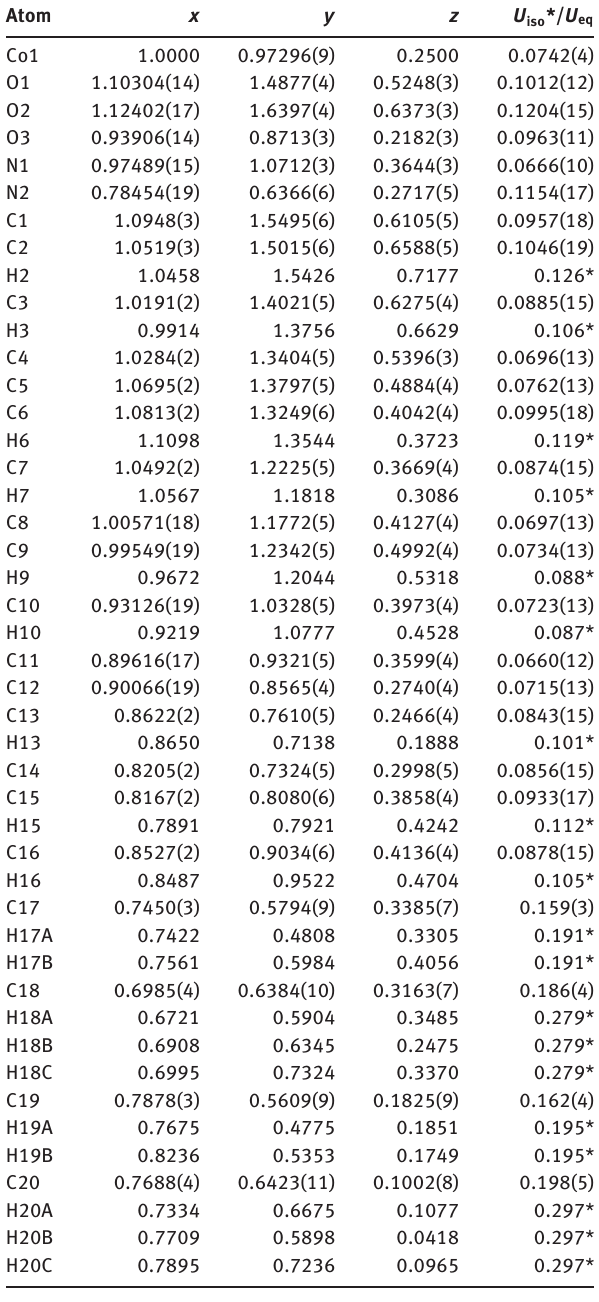
Table 2: Fractional atomic coordinates and isotropic or equivalent isotropic displacement parameters (Å 2